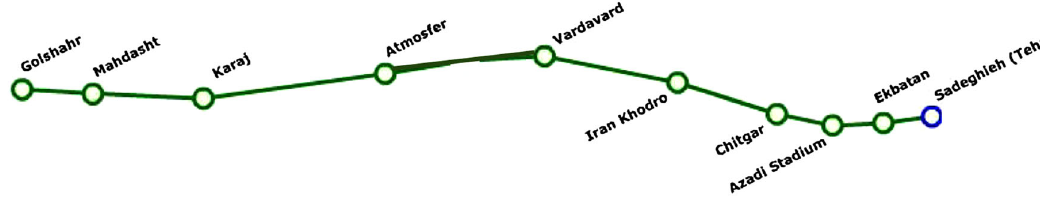
Fig. 1 Route map of the Line No.5 of Tehran metro